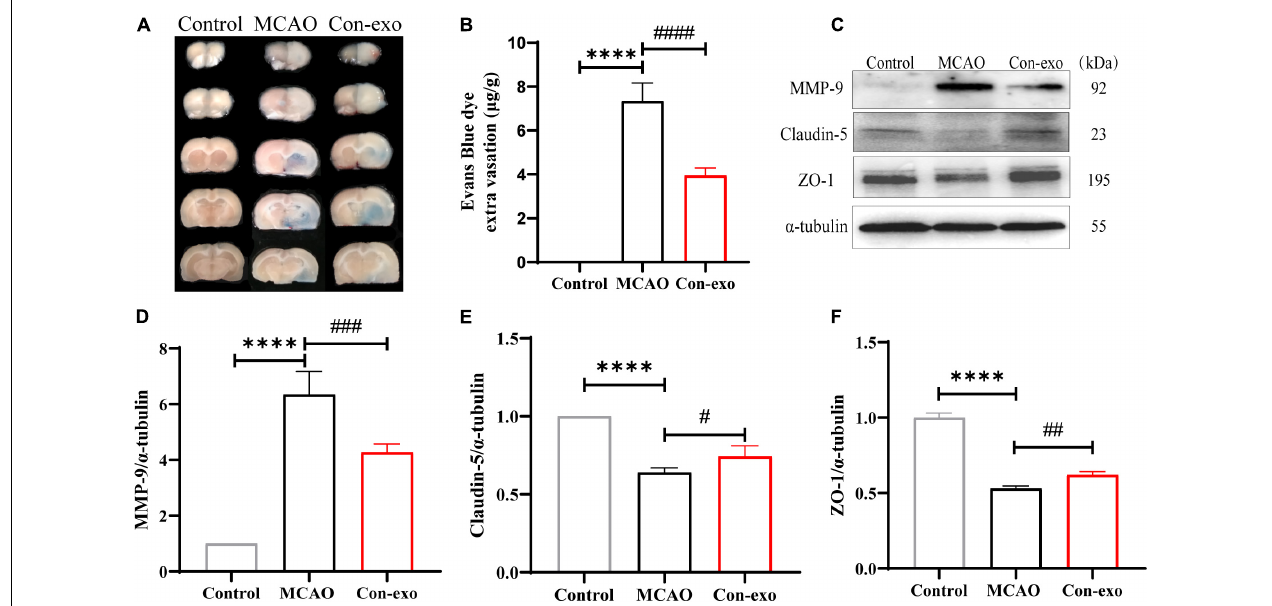
FIGURE 3 | Serum exosomes reduce the blood–brain barrier (BBB) leakage after ischemic stroke. (A,B) Representative images and quantitative analysis of the effect of Con-exo on Evans blue (EB) leakage in ischemic brains. (C–F) Immunoblotting and statistical analysis of the effect of Con-exo on matrix metalloproteinase-9 (MMP-9) (D) , claudin-5 (E) , and zonula occludens-1 (ZO-1) (F) Expression after ischemic injury. ∗∗∗∗ P < 0.0001 vs. control, # P < 0.05, ## P < 0.01, ### P < 0.001, #### P < 0.0001 vs. MCAO ( n =